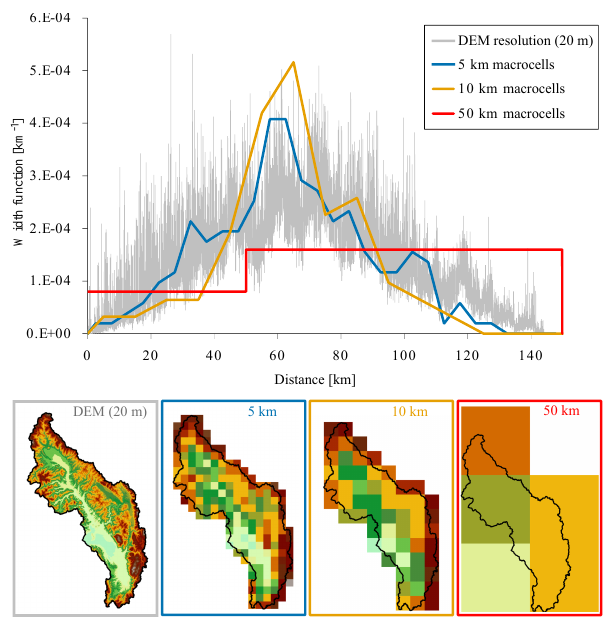
Figure 5. Width functions of the Upper Tiber river basin at Ponte Nuovo (PN) outlet (4116km 2 ) obtained aggregating the original 20m DEM to 5 (blue), 10 (orange), and 50 (red)km. The width function derived from the original 20m DEM is also shown (grey). Aggregated DEMs with grid size of 5, 10, and 50km are shown in the lower part of the